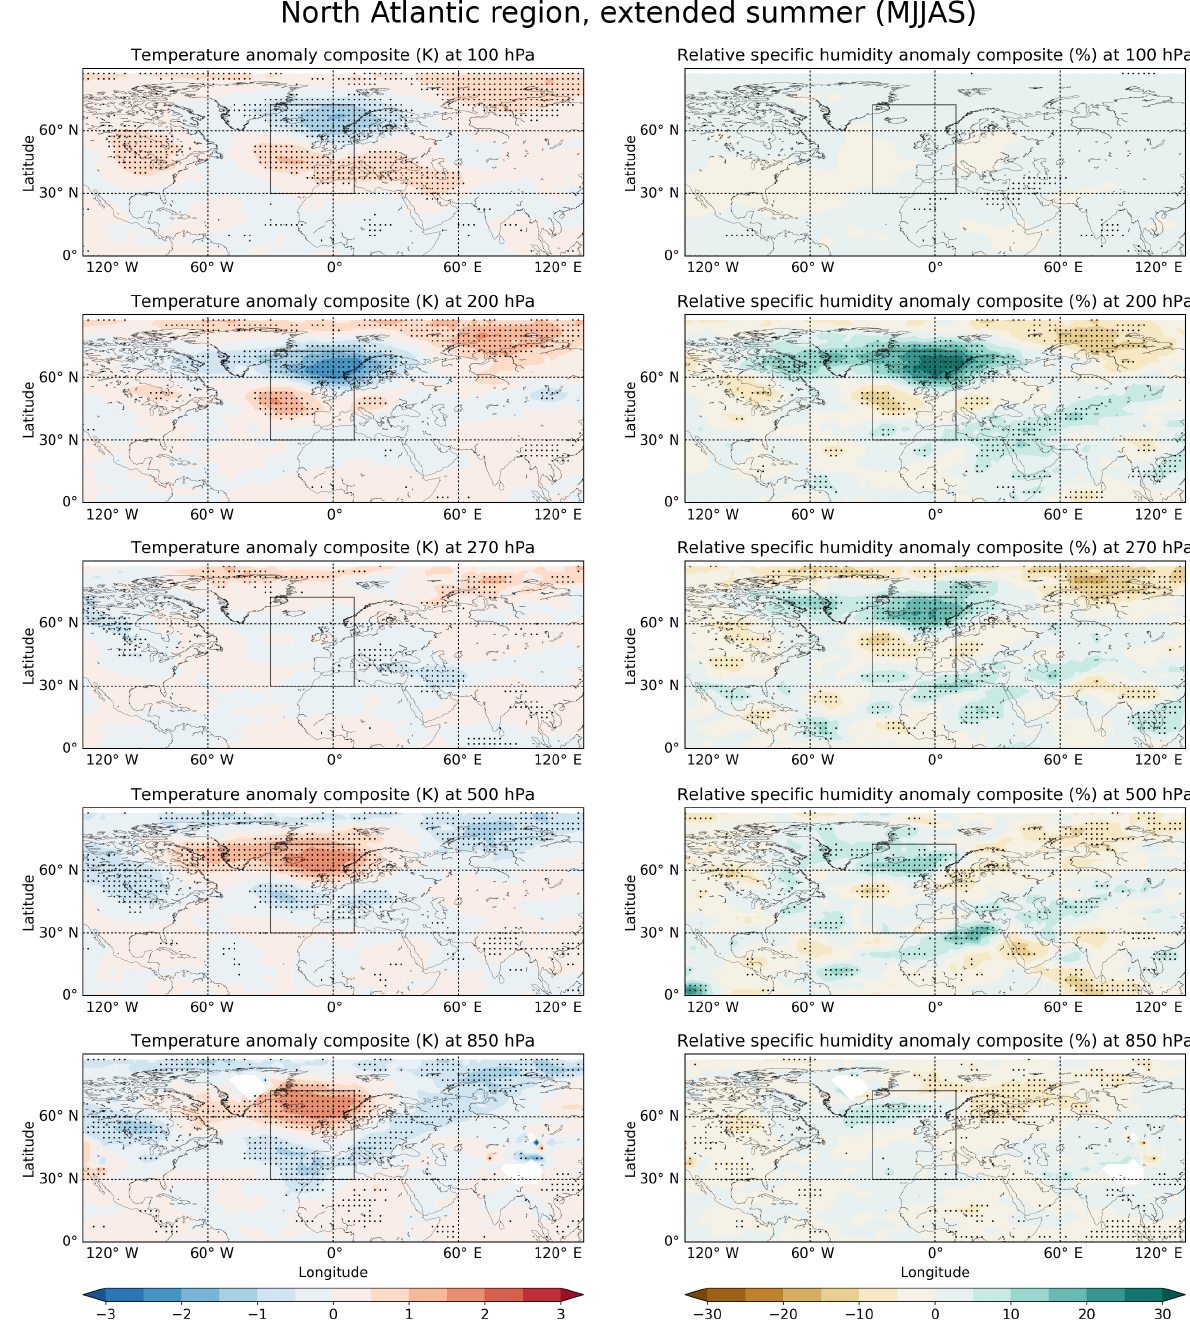
Figure 6. As Fig. 5 but for the extended summer (MJJAS) season (186 days in total).